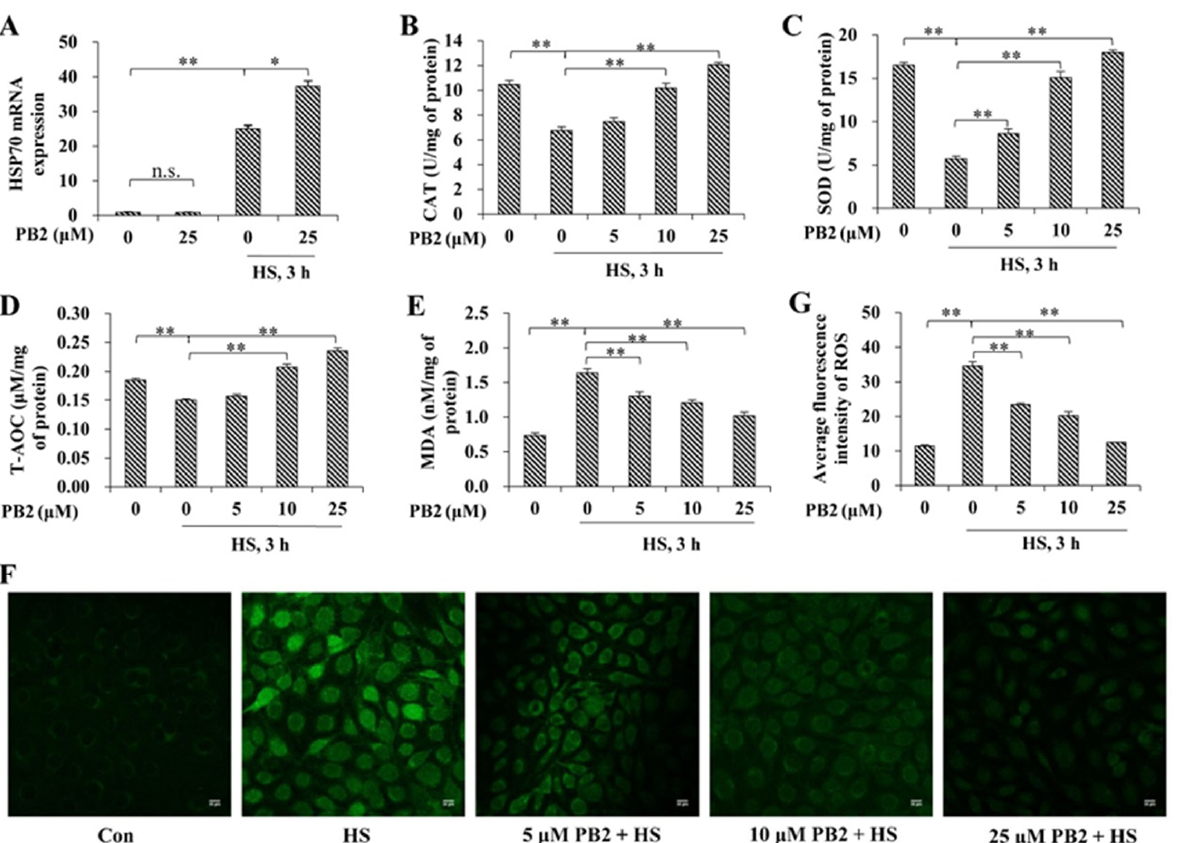
Figure 2. Effect of PB2 and HS on oxidative stress of MAC-T cells. ( A ) MAC-T cells were pre-incubated with or without 25 µ M PB2 for 24 h, followed by HS treatment at 42 ◦ C for 3 h and recovery at 37 ◦ C for 6 h. Then, cells were collected to detect HSP70 mRNA expressions ( n = 3). Additionally, MAC-T cells were pre-incubated with indicated concentrations of PB2 for 24 h, followed by HS treatment at 42 ◦ C for 3 h and recovery at 37 ◦ C for 6 h. Then, the cells were analyzed for: ( B ) the catalase (CAT) activity; ( C ) the superoxide dismutase (SOD) activity; ( D ) the total antioxidant capacity (T-AOC) activity; and ( E ) the malondialdehyde (MDA) content. ( F ) Images of the MAC-T cells stained with DCFH-DA were captured by a laser scanning confocal microscope, followed by relative florescence intensity assay ( G ). n ≥ 6. Scale bar: 50 µ m. * p < 0.05, ** p < 0.01, n.s. p > 0.05.